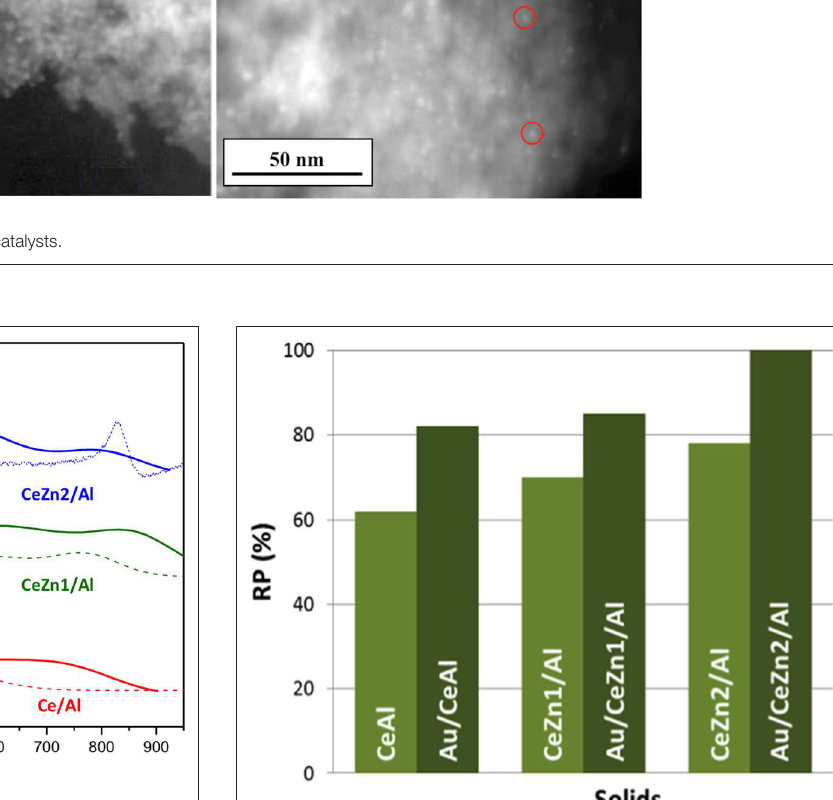
FIGURE 4 | Reducibility percentage (RP) of the prepared solids.